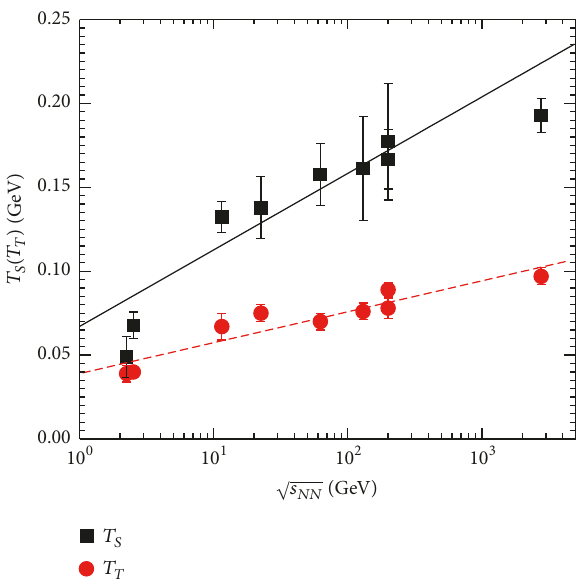
Figure 6: Same as Figure 5, but for the dependence of 𝑇 𝑆 (squares) and 𝑇 𝑇 (circles) on √𝑠 𝑁𝑁 and the linear functions are 𝑇 𝑆,𝑇 = 𝑎 ln √𝑠 + 𝑏 . 𝑁𝑁